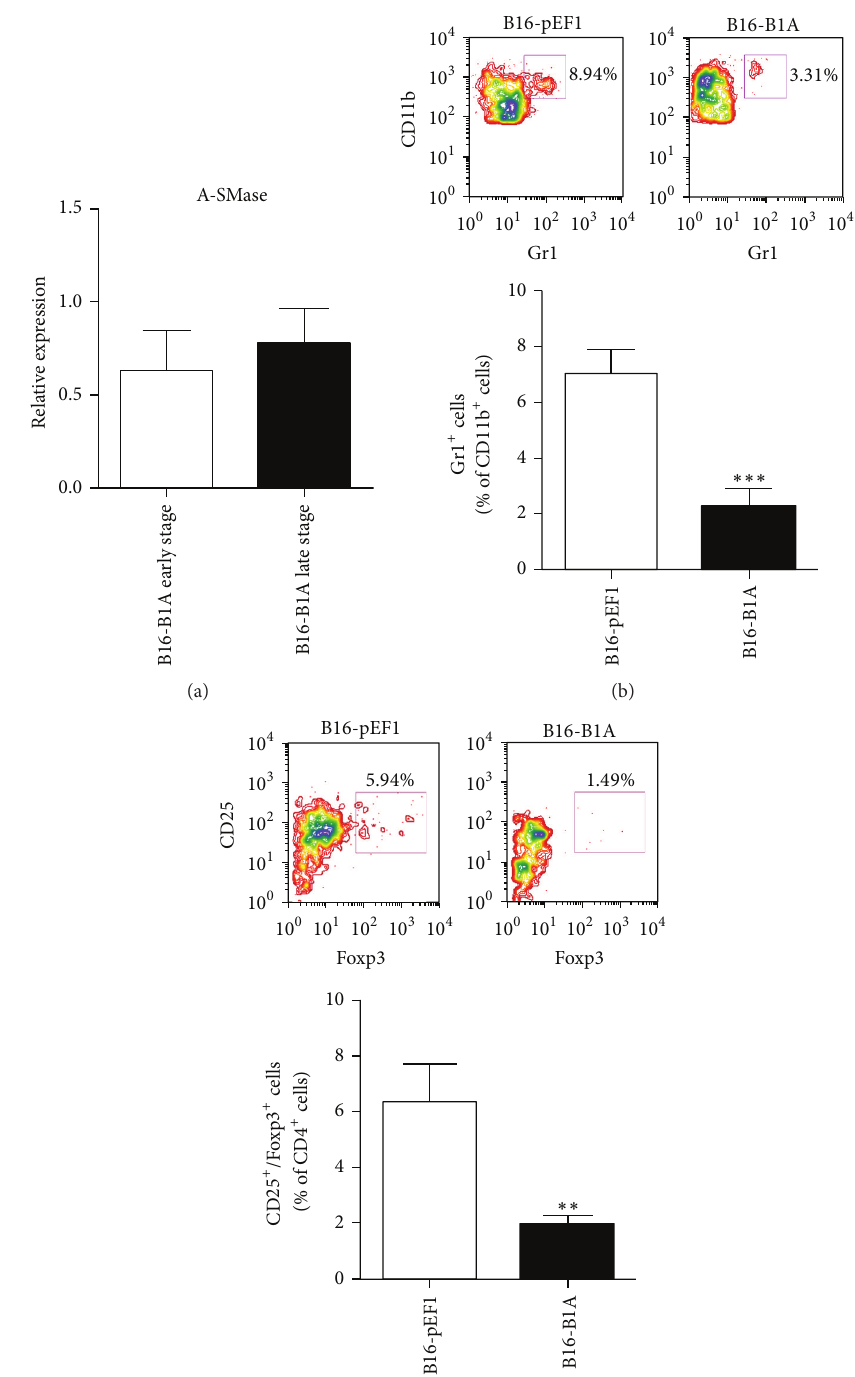
Figure 4: A-SMase expression reprogrammes the tumour microenvironment. (a) Analysis of A-SMase expression in B1A tumours in vivo . Tumours were resected when they reached the volume of ca. 500 mm 3 (early stage) or 1500 mm 3 . A-SMase expression was evaluated by qPCR. The histograms represent the data obtained from five to seven animals per experimental group. (b-c) Flow cytometry analysis of tumour- infiltrating immune cells. Tumour cell suspensions obtained from resected tumours were stained with the specific fluorescent conjugated antibodies for CD11b, Gr1, CD4, CD25, and Foxp3 antibodies. (b) A representative dot plot of CD11b + /Gr1 + cells in the CD11b + population cell is shown ( upper panel ). The histograms represent the data obtained from ten to fifteen animals per experimental group ( lower panel ). (c) A representative dot plot of CD25 + /Foxp3 + in the CD4 + cell population is shown ( upper panel ). The histograms represent the data obtained from ten to fifteen animals per experimental group ( lower panel ). Values in each histogram are expressed as mean ± SEM. ∗∗ 𝑃 < 0.01 versus B16-pEF1